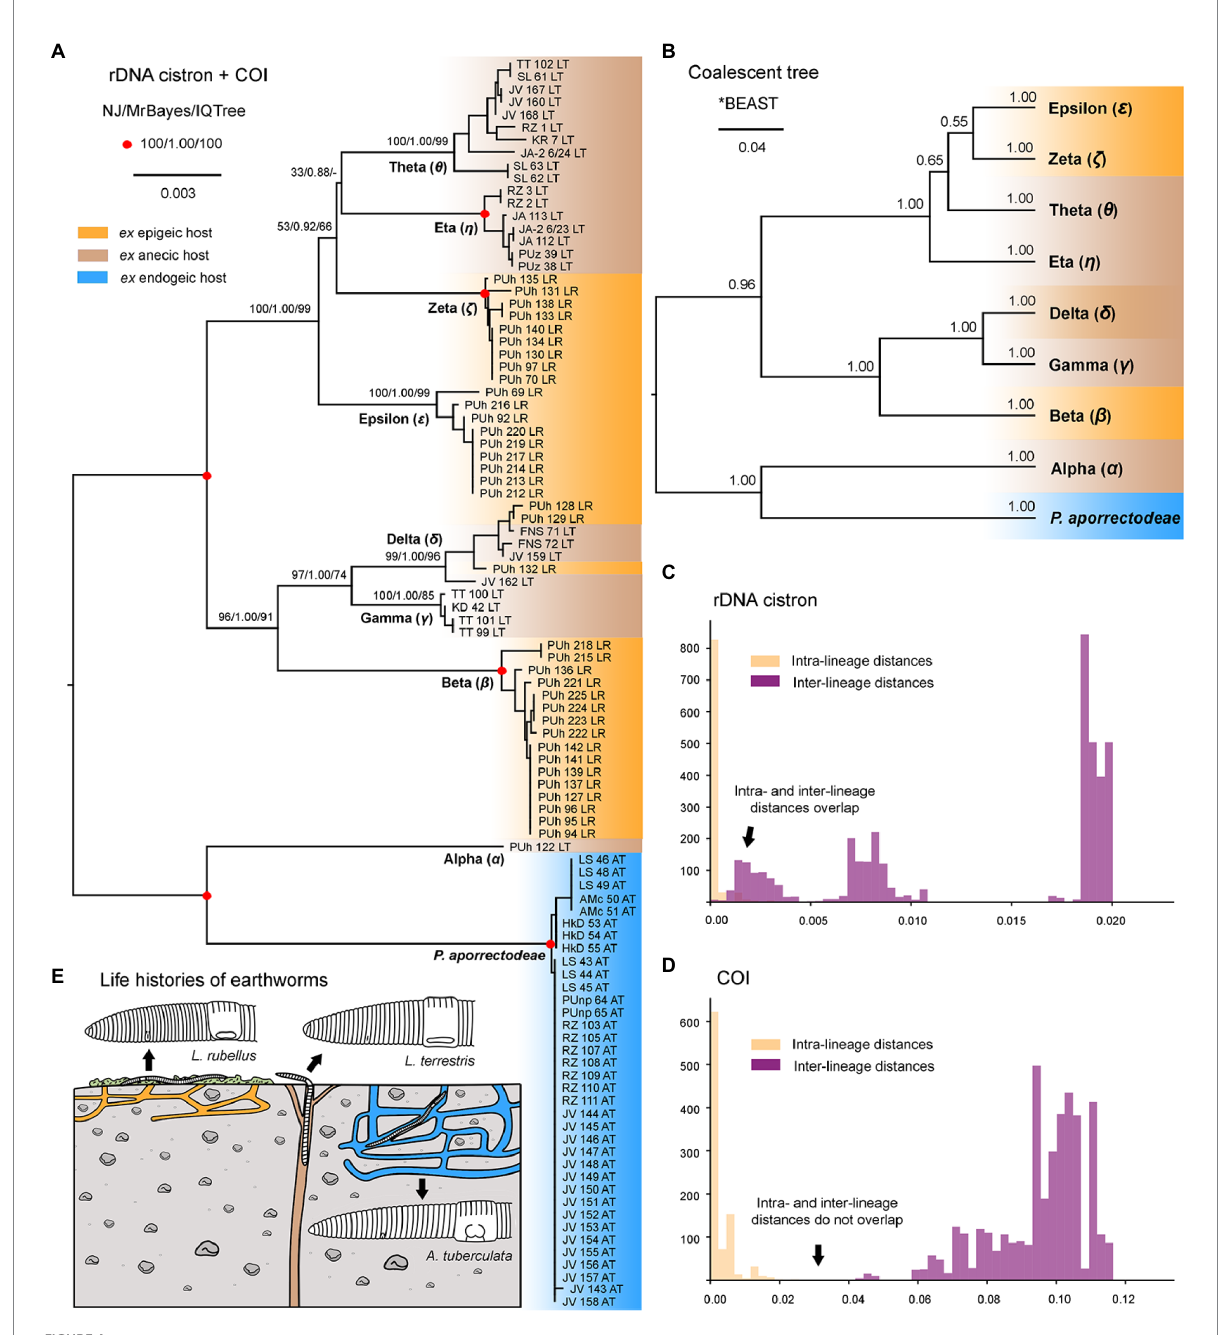
FIGURE 4 Phylogenetic relationships among plagiotomids isolated from three ecological groups of lumbricid earthworms. (A) Phylogenetic tree based on rDNA cistron and COI sequences of 99 specimens. Bootstrap values for neighbor-joining (NJ) conducted in MEGA X and for maximum likelihood conducted in IQ-TREE as well as posterior probabilities for Bayesian inferences conducted in MrBayes are listed at corresponding nodes of the NJ tree. Note that after exclusion of just 16 hybrid specimens, the multi-gene trees became very well resolved and statistically supported. (B) Coalescent species tree based on rDNA cistron and COI sequences of 99 specimens. Posterior probabilities of clades are provided along internal branches, while posterior probabilities for the presence of individual species (lineages) are provided above the terminal branches. Scale bars denote the fraction of substitutions per site. (C, D) Histograms showing intra- and inter-lineage p -distances of rDNA cistron and COI gene sequences of 99 specimens. Individual Plagiotoma lineages could not be unambiguously delimited by barcoding analyses of the rDNA cistron per se , as intra- and inter-lineage distances partially overlapped. On the other hand, a very distinct barcoding gap was revealed in the COI dataset, whereas the maximum intra-lineage distance was 2.33% while the minimum inter-lineage distance was 4.27%. (E) Earthworm life strategies. Epigeic earthworms form no or only a few burrows and feed on decomposing organic material, anecic earthworms live in permanent, vertical burrows and emerge on the soil surface to feed on dead organic materials mixed with soil, and endogeic earthworms produce a temporary, horizontally oriented burrow systems and feed on soil. Colors denote the individual ecological group of